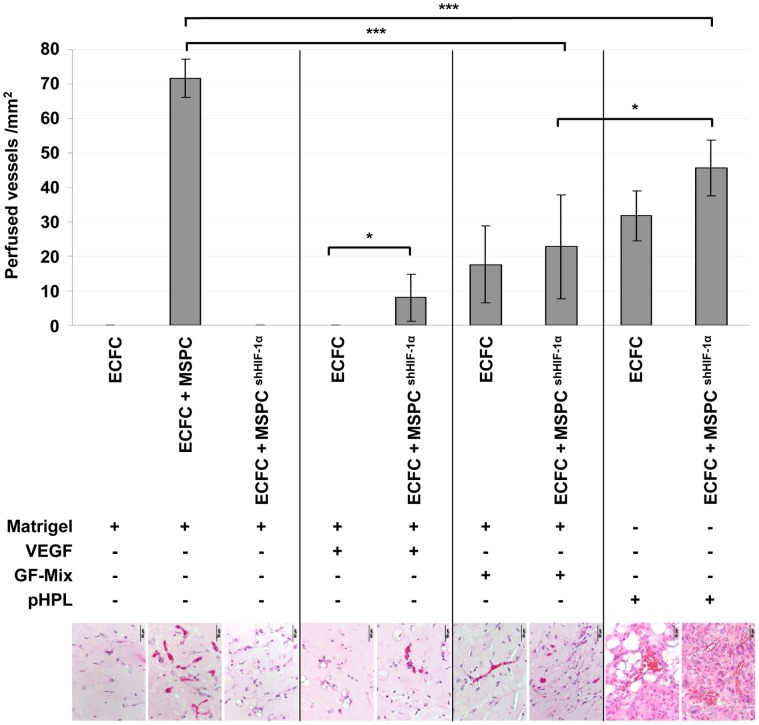
Angiogenic factors can partially substitute MSPC HIF-1α deficiency in vivo.ECFCs alone or in combination with MSPCs (either un-manipulated or after shHIF-1α knockdown) were (co)-transplanted in either Matrigel or pooled human platelet lysate (pHPL) gel with or without additional growth factors (GF) as specified. The GF-Mix comprised VEGF, EGF, IGF, FGF-2, hydrocortisone and ascorbic acid. Mean ± SD results of the number of perfused vessels counted in five high power fields (200x, at least two independent plugs and two independent animals). Microphotographs correspond to the treatment group (scale bar 50 µm; ***p<0.0001, *p<0.05).